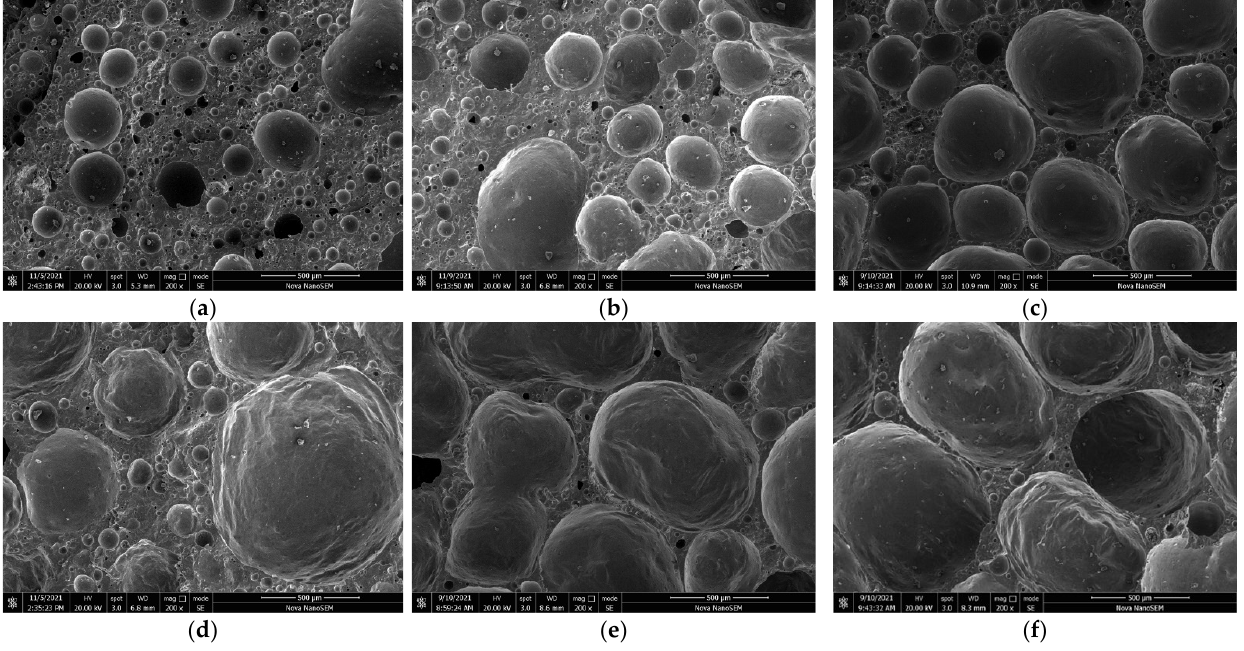
Figure 7. Interior microstructures of ceramsite at different sintering temperatures: ( a ) 1220 °C, ( b ) 1230 °C, ( c ) 1240 °C, ( d ) 1250 °C, ( e ) 1260 °C, ( f ) 1270 °C.